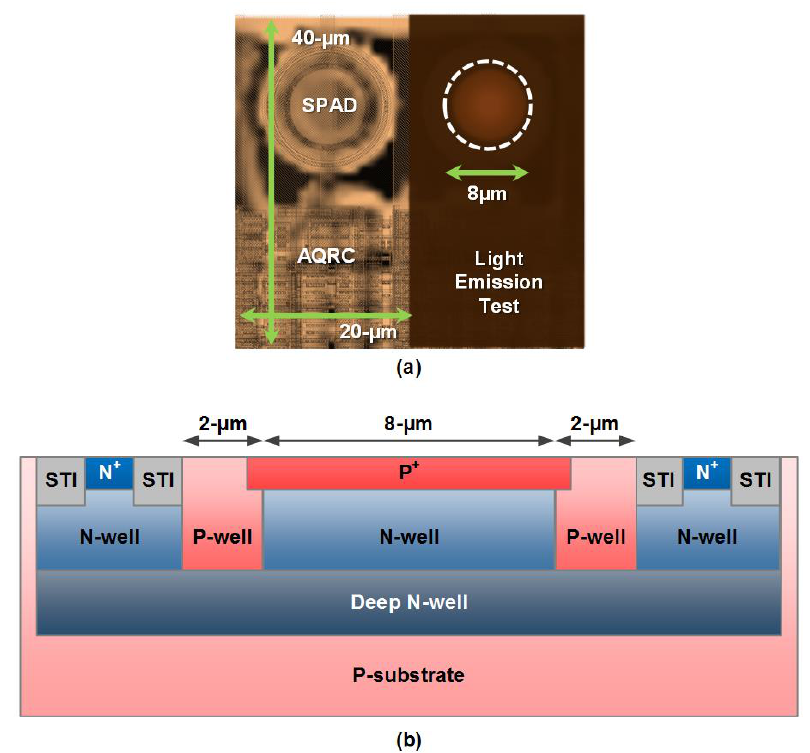
Figure 1. ( a ) Microscope image of the fabricated single-photon sensor and the light emission test result; ( b ) Cross-sectional view of a single-photon avalanche diode (SPAD).